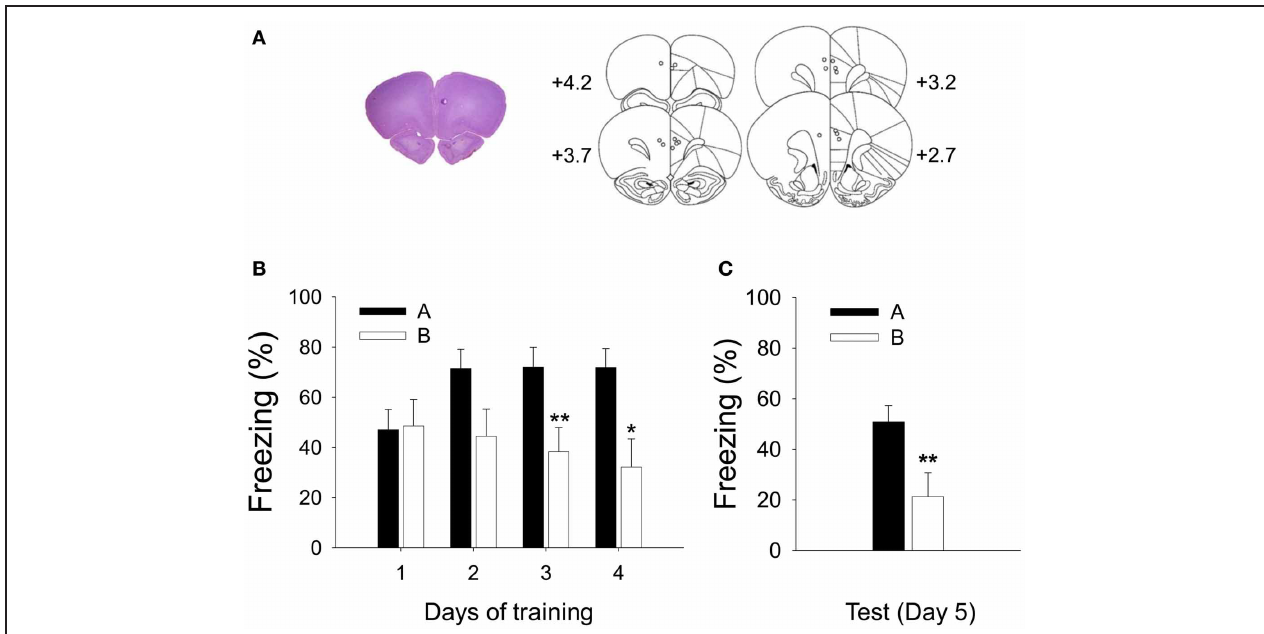
CDFD was developed following 4 days of training as all animals exhibited significantly greater freezing to the CS in Context A than in Context B on days 3 and 4. (C) On the test session, they also showed significantly more freezing to the CS in Context A than in Context B. ∗ and ∗∗ denote p < 0 . 05 and p < 0 . 01,